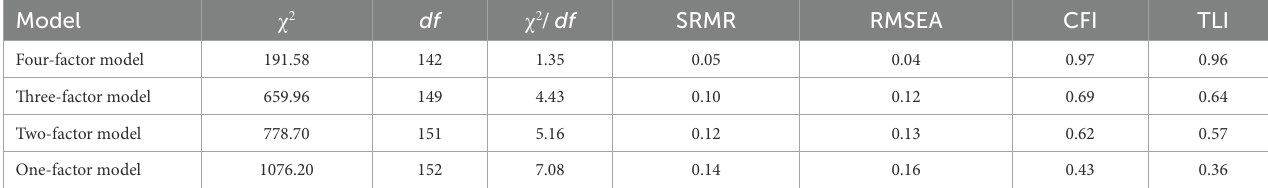
TABLE 2 Results of reliability and convergence validity of each